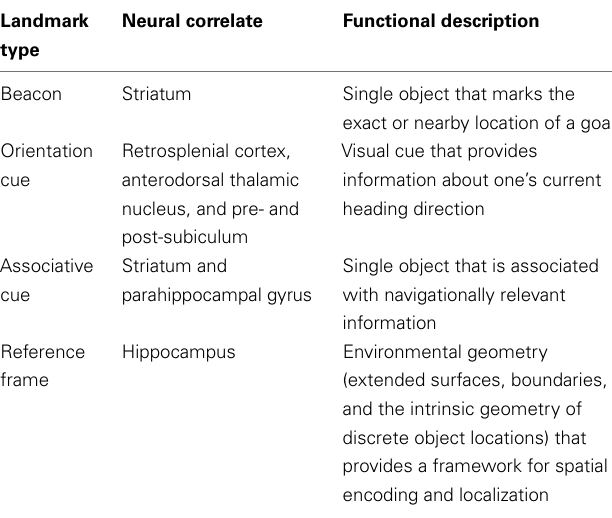
Table 1 | Proposed four-part taxonomy of landmark function in